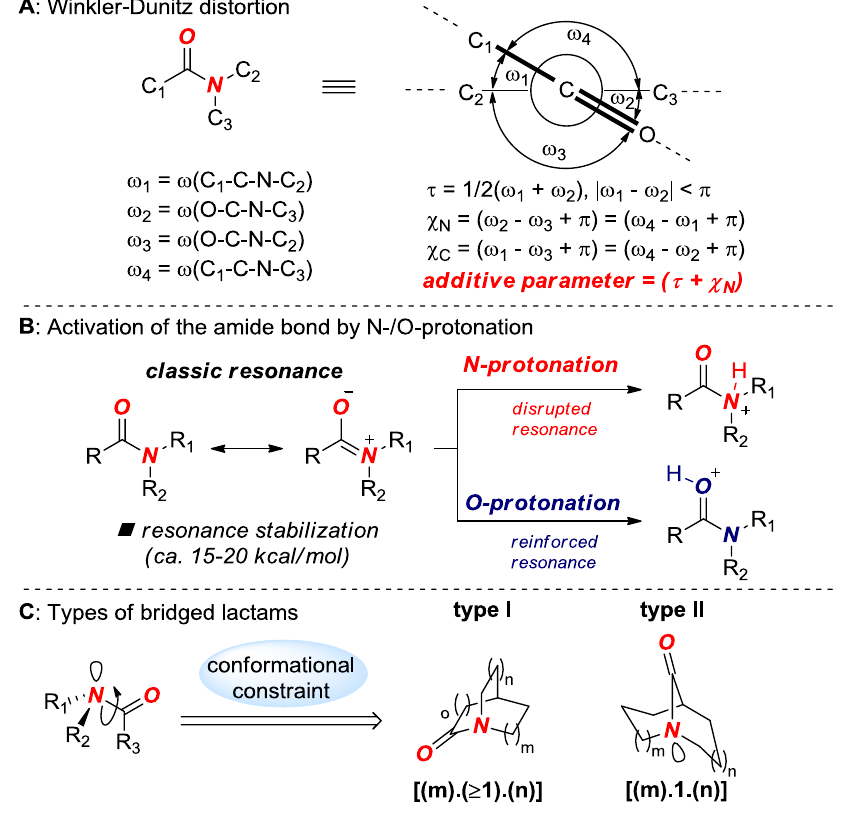
Figure 2. ( A ) Winkler-Dunitz Distortion. ( B ) Activation of the Amide Bond by N -/ O -Protonation. ( C ) Types of Bridged Lactams.